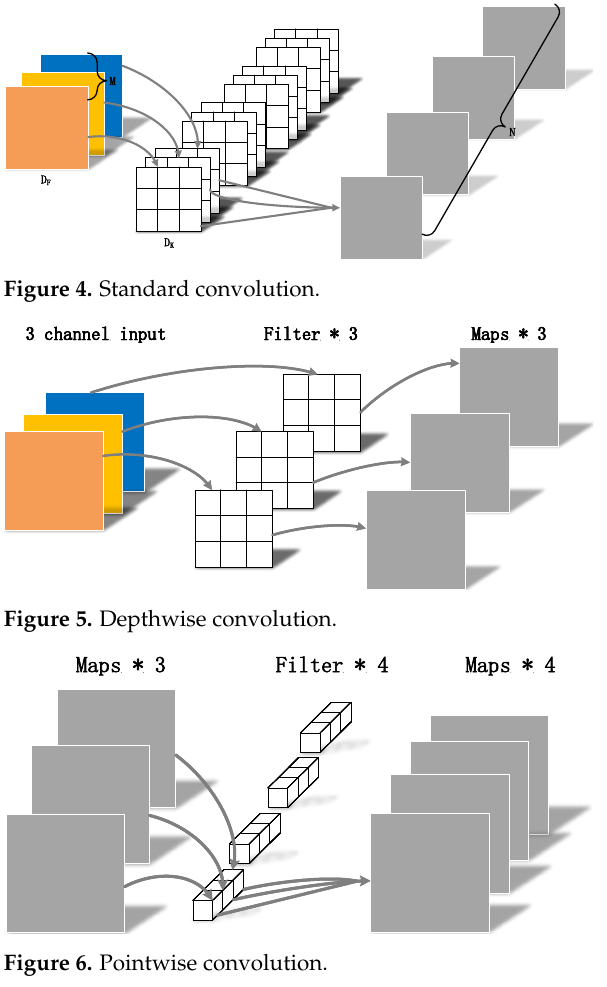
Figure 6. Pointwise